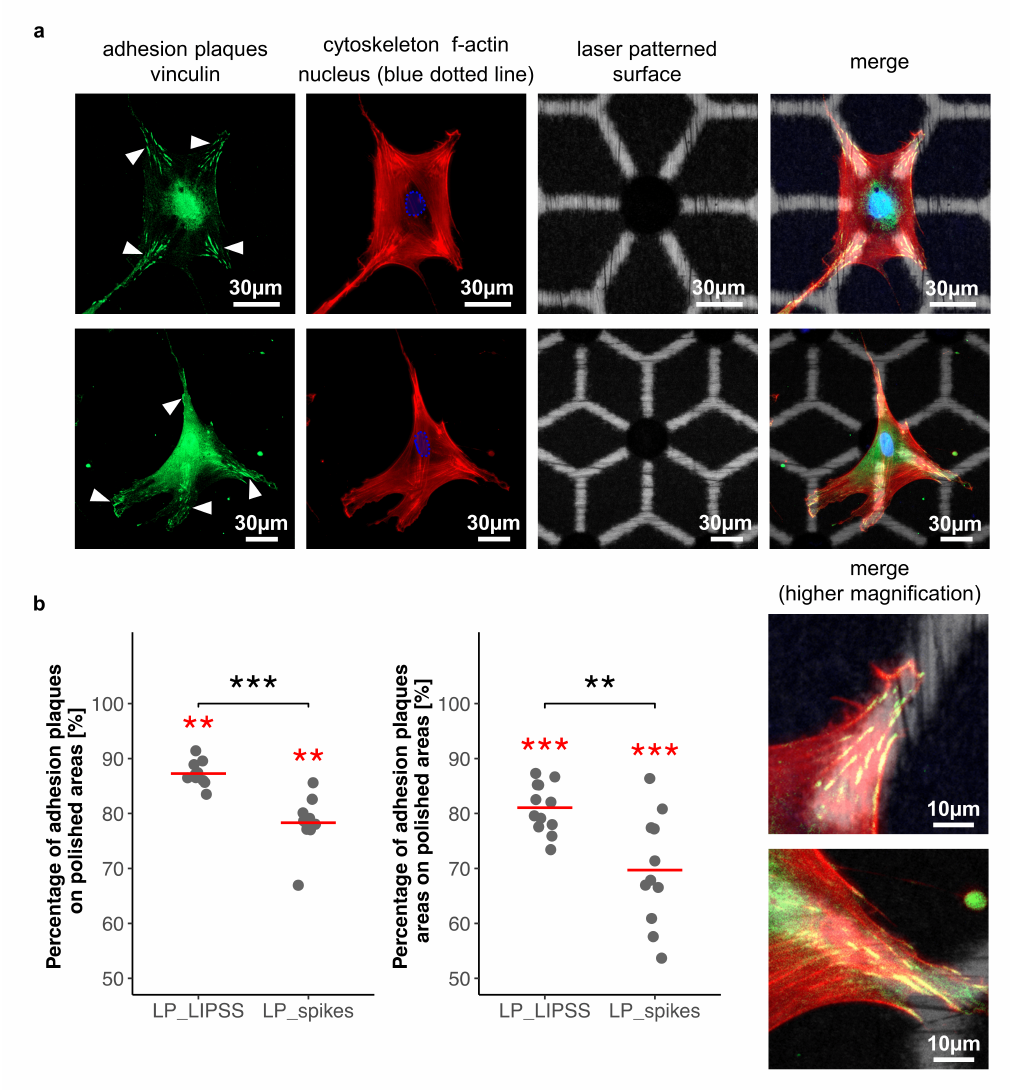
Figure 6. Quantification of focal adhesion repartition between polished areas and laser-nanostructured ones on laser-patterned surfaces. ( a ) Two representative cells 48 h after seeding on laser-patterned surfaces. Focal adhesions (white arrows) mostly located on polished areas. Nucleus in blue dotted line located inside the micro-pit. Cytoskeleton with a star like shape in red. Laser patterned surface with polished areas in white and nanostructured areas in black. ( b ) Ratio of adhesion plaques on polished regions compared to adhesion plaques on laser-nanostructured ones was obtained either by counting the number of adhesion plaques per cell (left panel) or by measuring the areas of the adhesion plaques per cell (right panel). A total of 760 focal adhesions were analyzed on LP_LIPSS and 665 on LP_spikes. Values were normalized according to the proportion of polished and laser-nanostructured regions on each sample. The Mann–Whitney U statistic tests were performed. Red lines denote mean